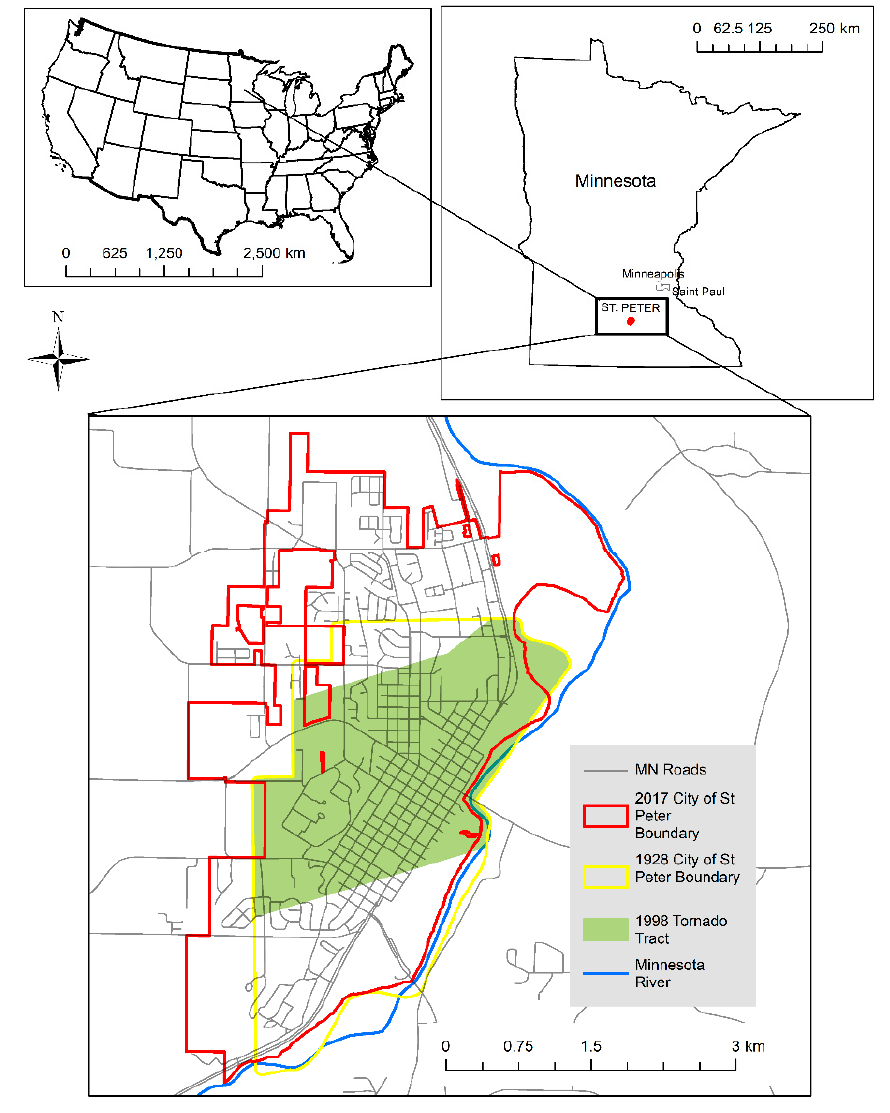
Figure 1. Location of research area.